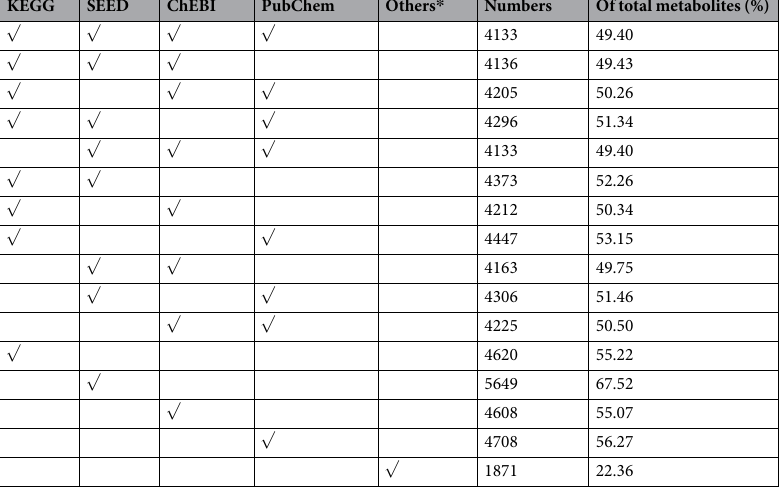
A list of reactions, including the Gene–Protein–Reaction relations for the models, should contain 15 columns of information, e.g., a reaction description, formula, and genes 26 . For the formula column, metabolites are first replaced and rearranged according to their unified IMGMD database metabolite IDs. Additionally, because some information was lacking, data (e.g., gene data) were collected by referring to information such as EC numbers,